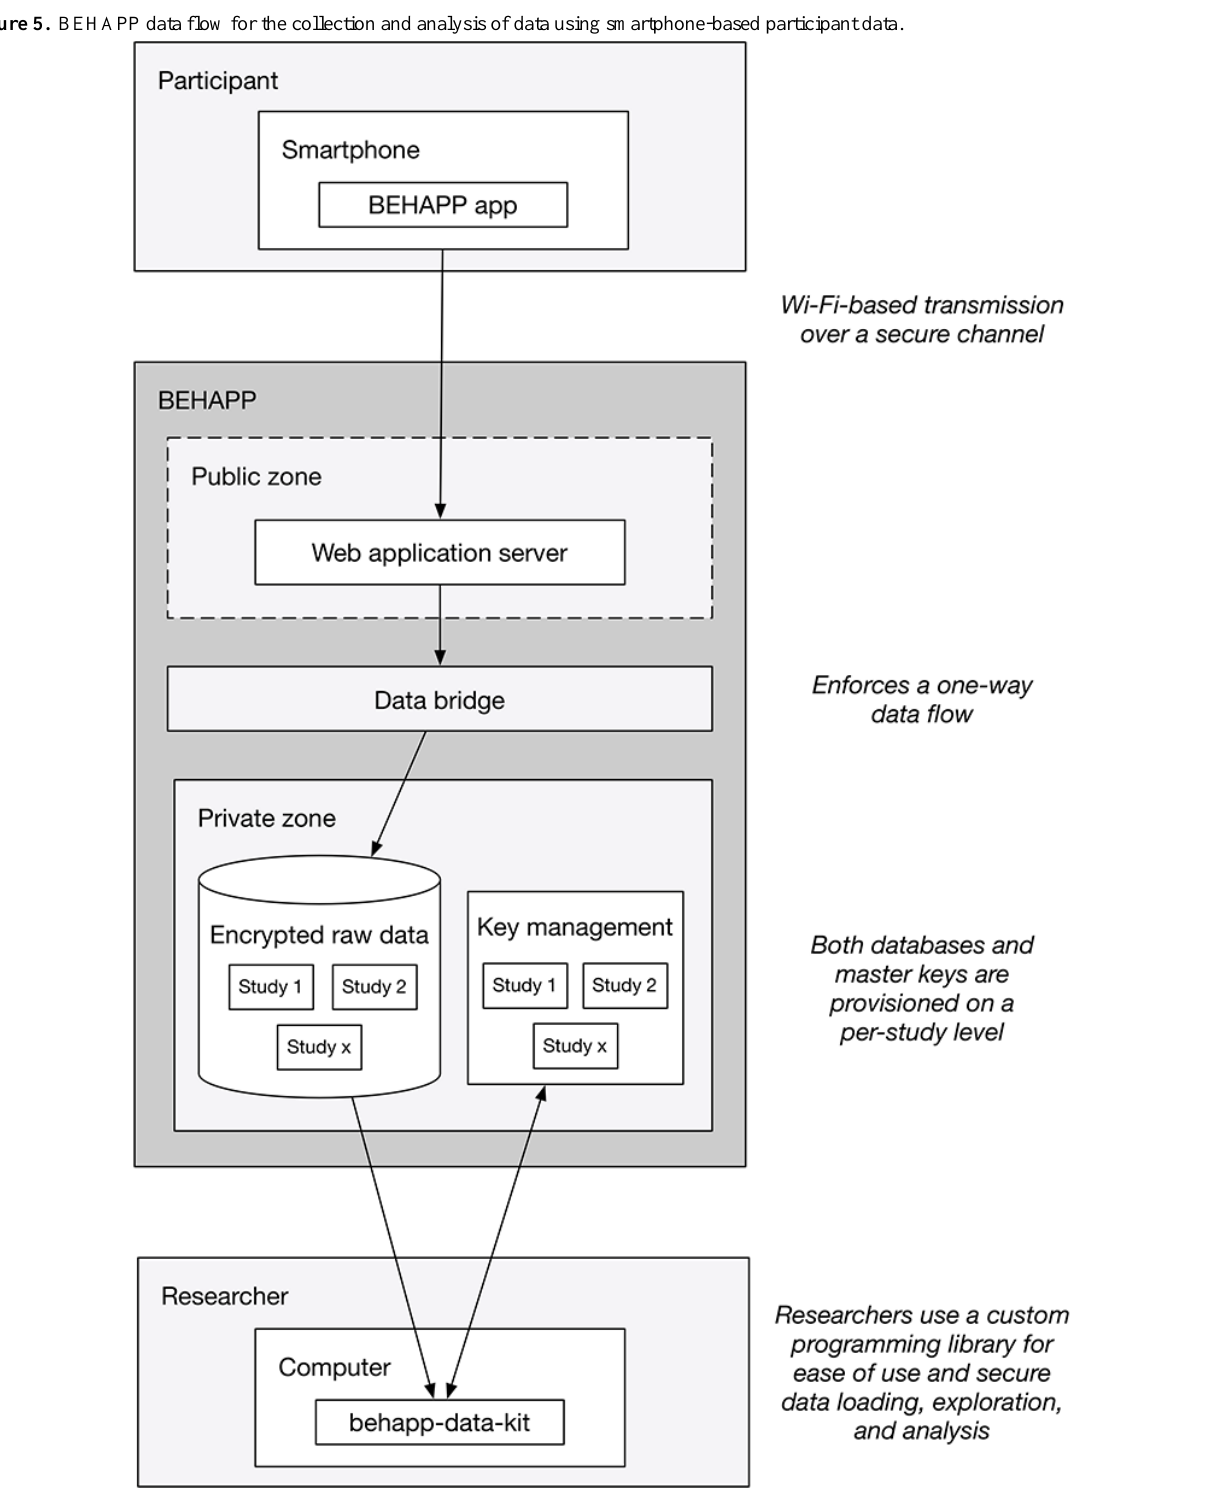
Figure 5. BEHAPP data flow for the collection and analysis of data using smartphone-based participant